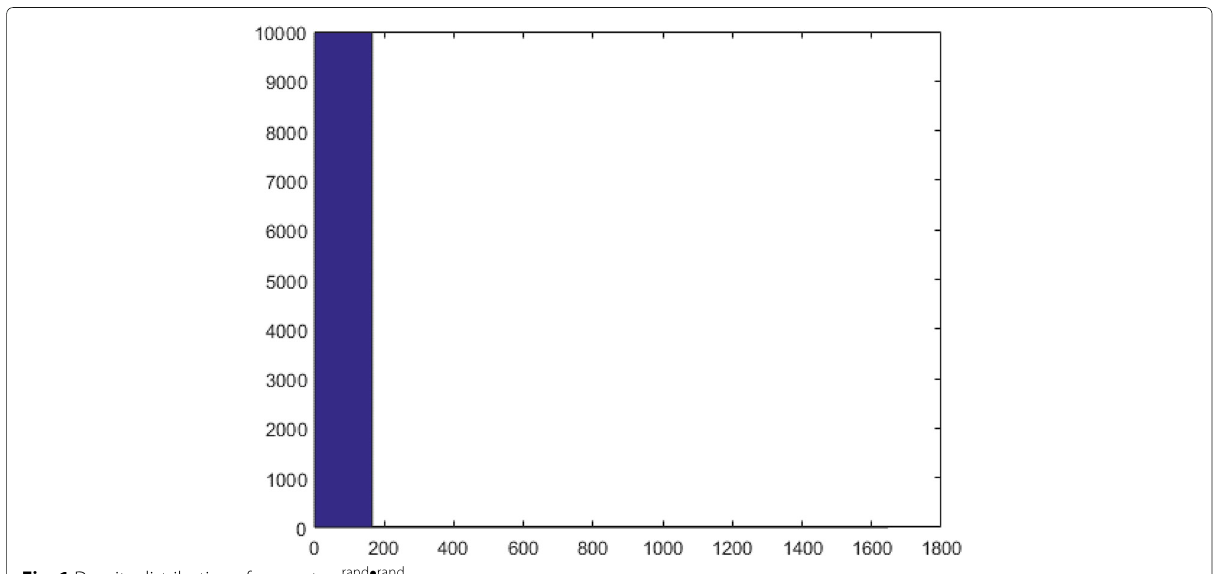
Fig. 1 Density distribution of generator rand • rand